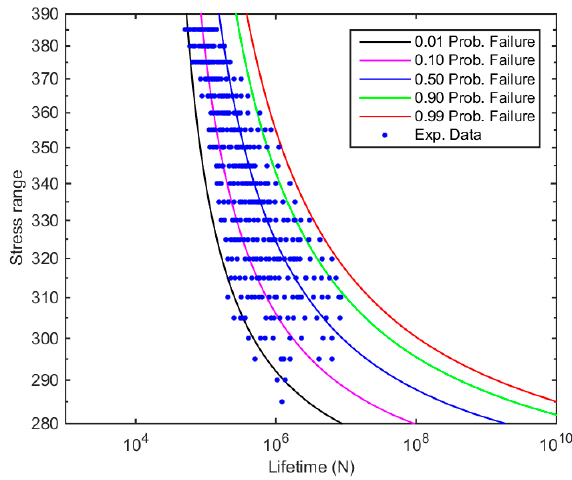
Figure 6. p-S-N field obtained by the standard approach of the Castillo–Canteli Model.